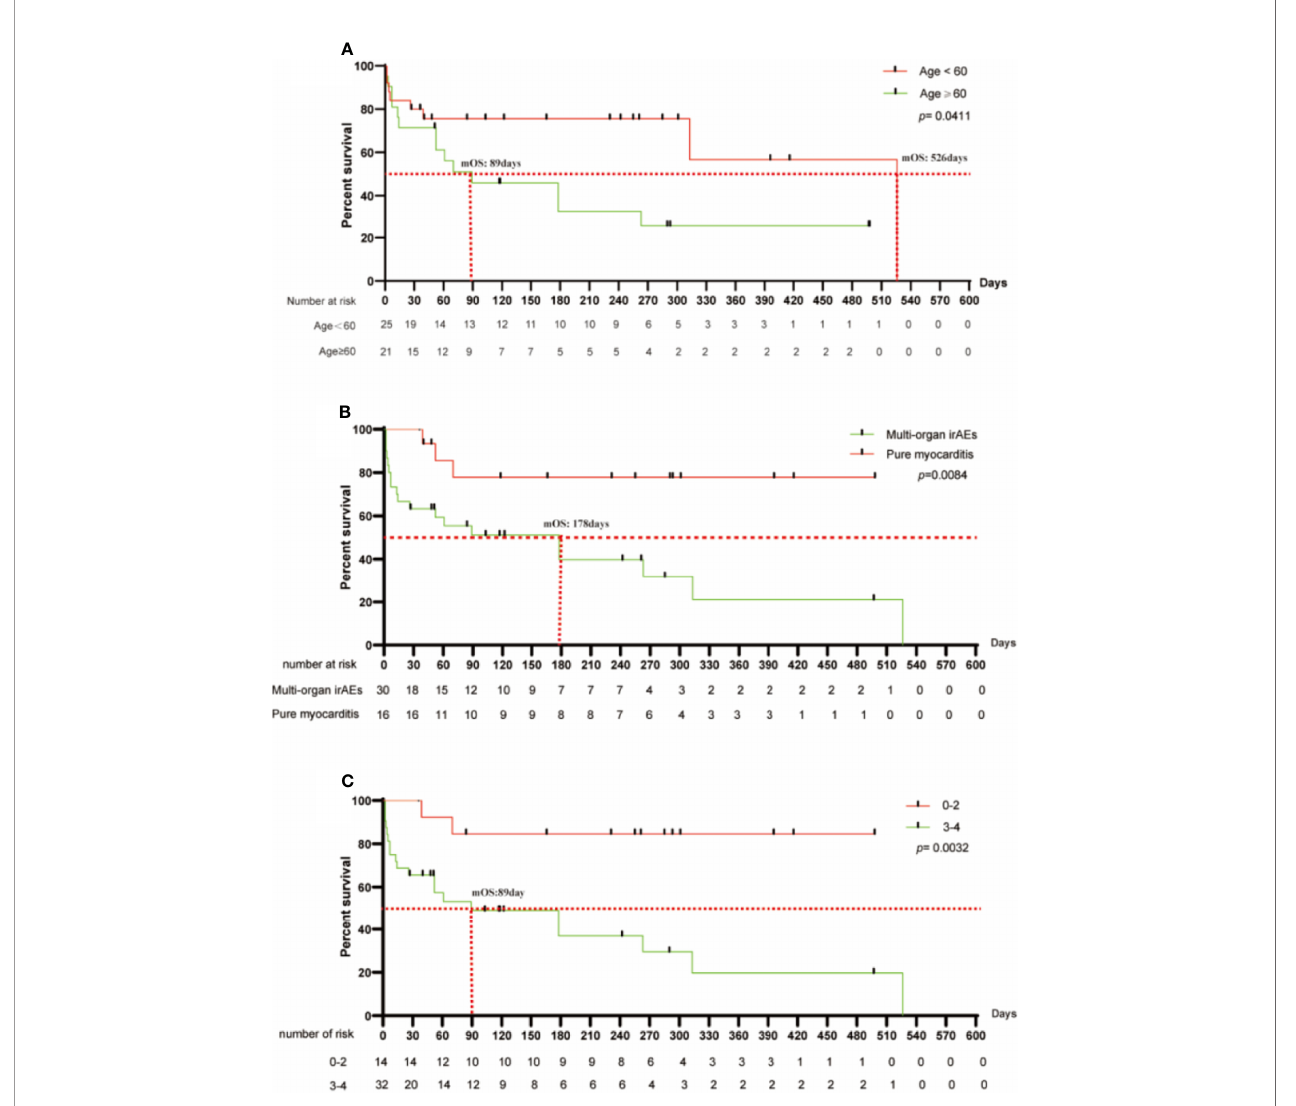
FIGURE 2 | Survival analysis of ICI myocarditis by strati fi cations. (A) In strati fi cation of age, the mOS of the <60 group was signi fi cantly longer than that of the ≥ 60 group (526d versus 89d, p=0.041). (B) In the strati fi cation of irAEs, multi-organ irAEs have a worse prognosis than pure myocarditis, with an mOS of 178d and not reached. (C) In the strati fi cation of heart failure, heart failure (grade 3-4) has a worse prognosis, with an mOS of